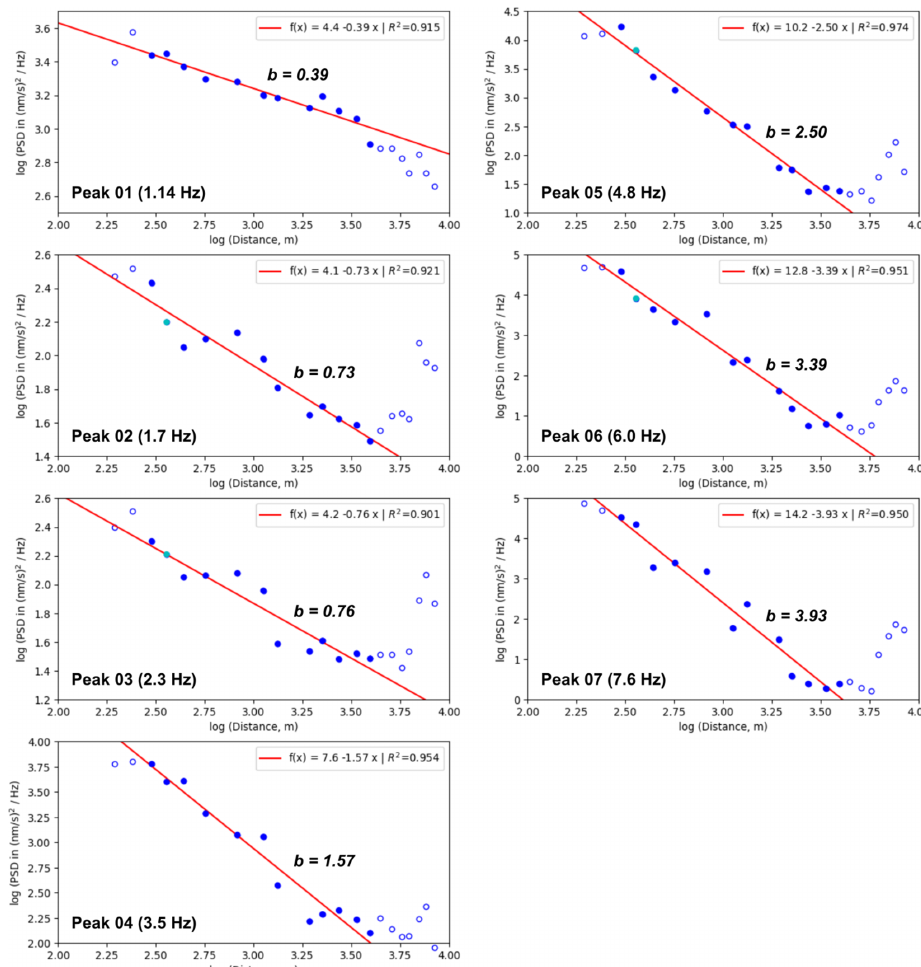
Figure 4. Double logarithmic representation of PSD amplitude decay at seven different peak frequencies. Blue circles mark the measured amplitudes from station F01 (194m) to station F19 (8413m) at full power status of the WT. Filled symbols denote data points that were used for power law fitting (red lines) between station F02 (301m) and F12 (3944m) with attenuation factor b and correlation coefficient R 2